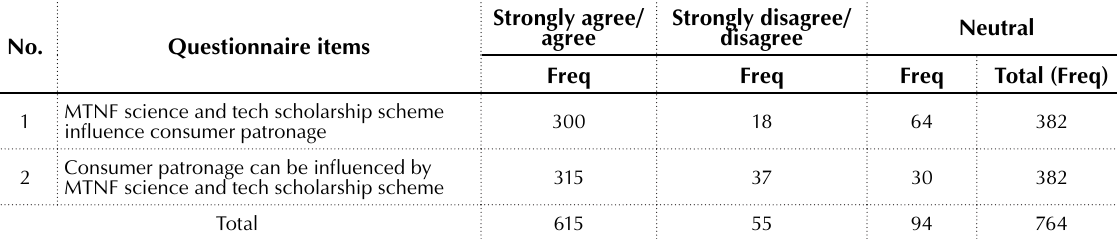
Source: Fieldwork (2018).